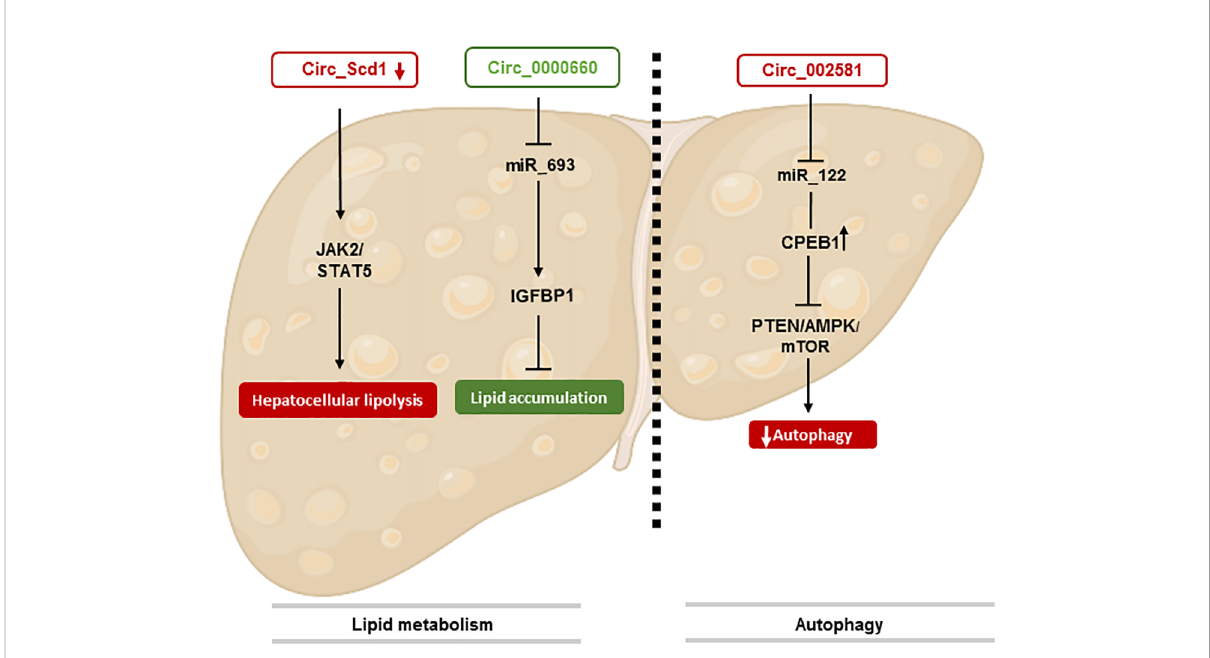
FIGURE 1 CircRNAs involved in NAFLD stage. This fi gure represents the effect of circRNAs in lipid metabolism through different pathways. The identi fi cation of circRNA involved in autophaghy is also